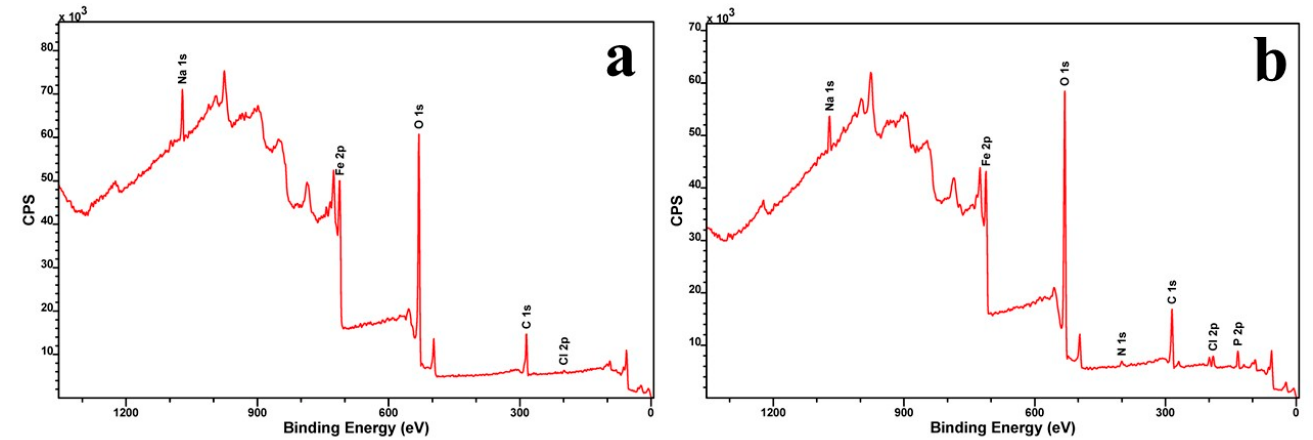
Figure 4. XPS surveys of S235 low-carbon bare steel after five days of immersion in 3.5% NaCl ( a ) for blank solution and ( b ) a solution with ATP-6-AHA.